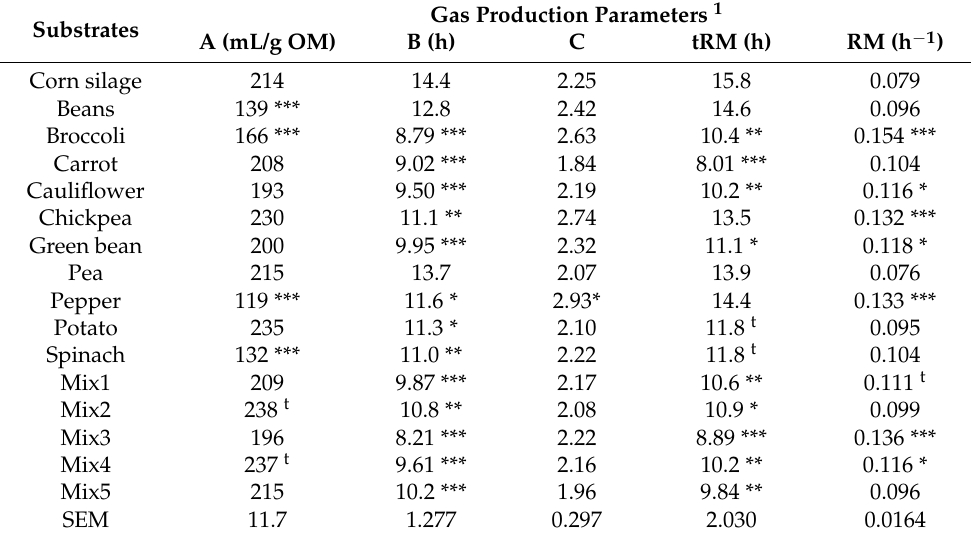
Table 5. In vitro gas production profile of corn silage and vegetable by-products.